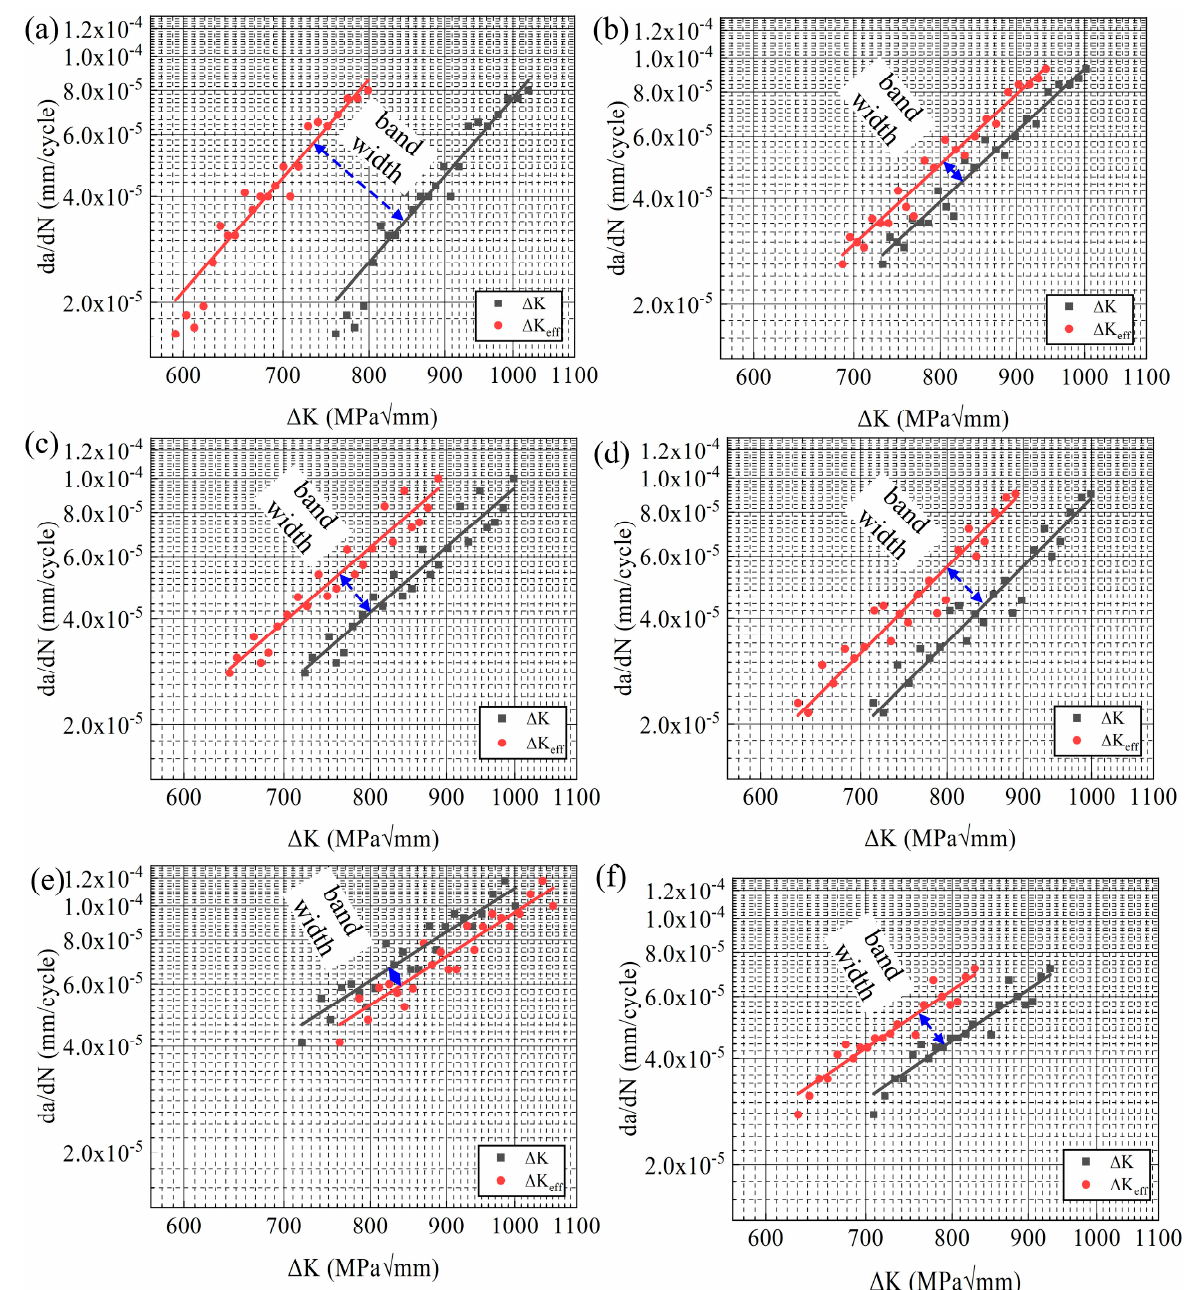
Figure 13. Calculation of da/dN- Δ K curves based on Paris theory and calculation of da/dN- Δ K curves based on Elber theory correction: ( a ) specimen B1; ( b ) specimen W1; ( c ) specimen B2; ( d ) W2 specimens; ( e ) B3 specimens; ( f ) W3 specimens.